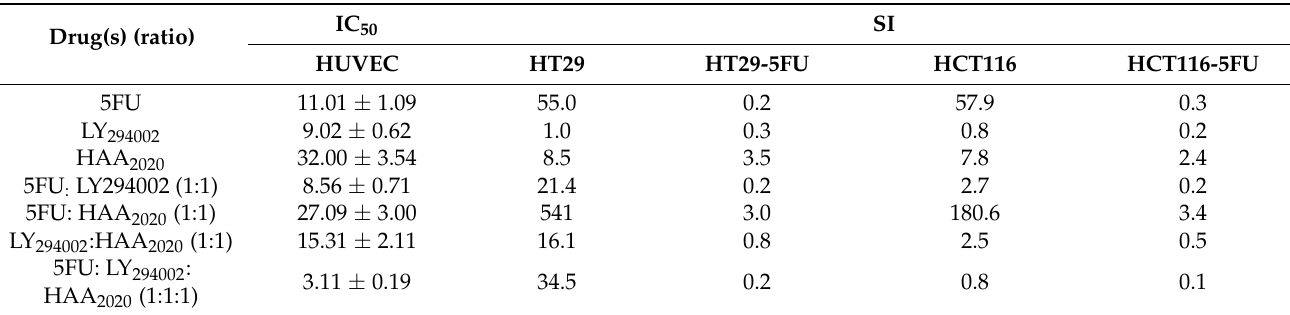
Table 6. IC 50 values (72 h mean ± SD, µM) and selectivity index of 5FU, LY294002, HAA 2020 , and their combinations in HUVEC cells.